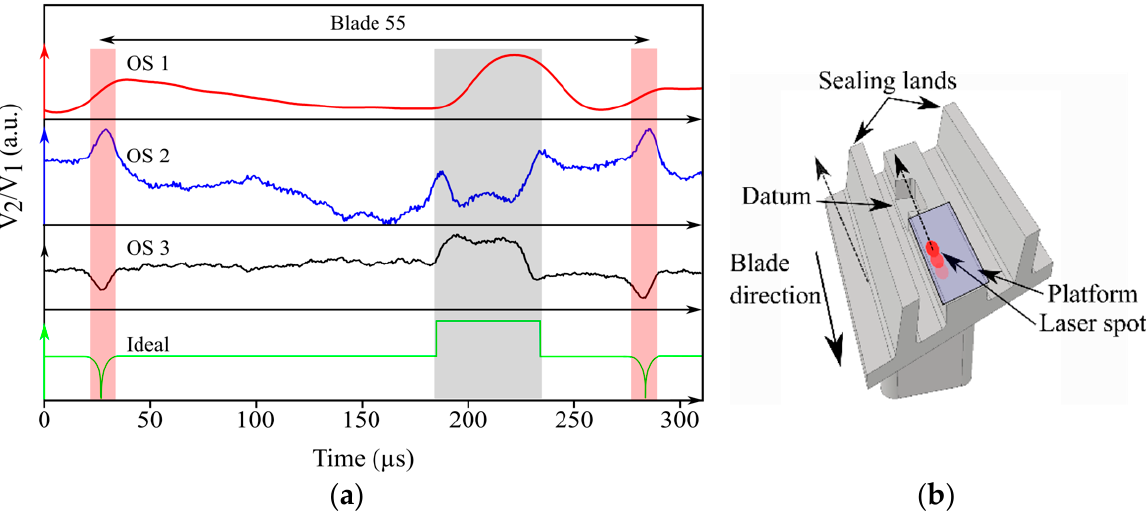
Figure 6. ( a ) Response curve of the different three optical sensors OS 1, OS 2 and OS 3 to the passing of a blade. The datum and inter-blade spacing are highlighted as grey and red-shaded areas, respectively. ( b ) 3D model of the blade and travel path of the light beam emitted by the emitter fibre. Table 2. Errors of OS 1, OS 2 and OS 3 while detecting the blade speed blade by blade.